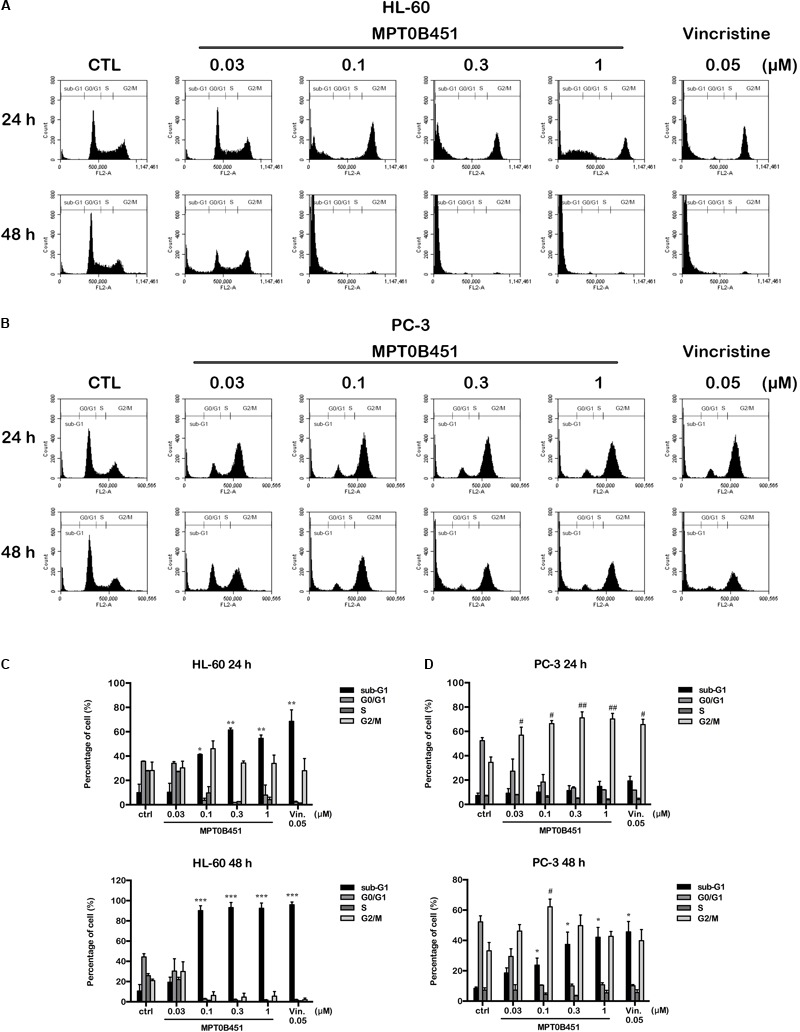
The kinetic changes of cell cycle under MPT0B451 treatment. The histograms of cell cycle distribution were detected by flow cytometry. (A) HL-60 and (B) PC-3 cells were treated in indication concentrations of MPT0B451 (0.03, 0.1, 0.3, and 1 μM) or vincristine 0.05 μM for 24 and 48 h, respectively. The data were expressed at least three separate determinations. The statistical data of cell cycle distribution. (C) HL-60 and (D) PC-3 were cultured in MPT0B451 or vincristine for 24 and 48 h. The data were repeated at least three independent experiments. ∗p < 0.05, ∗∗p < 0.01 and ∗∗∗p < 0.001 compared with sub-G1 untreated group; #p < 0.05 and ##p < 0.01 compared with G2/M untreated group.